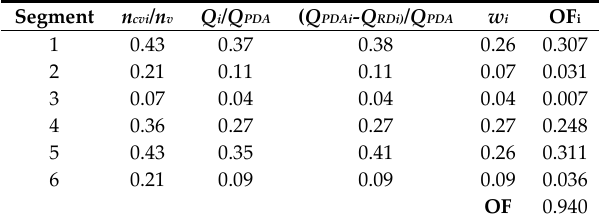
Table 3. Terms to calculate OF for the scenario